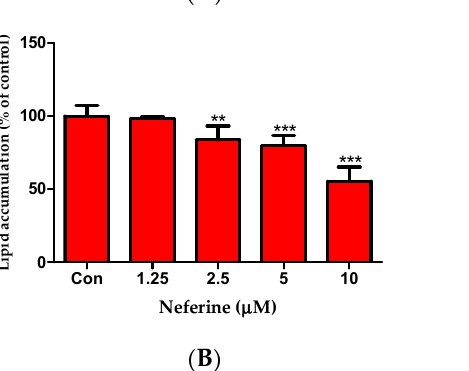
Figure 2. Effects of neferine on intracellular lipid accumulation. ( A ) Lipid droplets were measured by Oil Red O staining. Cell were treated with neferine at concentrations of 1, 2.5, 5, and 10 μ M. Scale bar indicates 100 μ m. ( B ) Relative lipid content is expressed as percentage. ** p < 0.01 and *** p < 0.001 vs. Con. All data are presented as mean ± SD, and experiments were performed at least thrice. The positive control (Con) was differentiated 3T3-L1 cells treated with adipocyte differentiation cocktail.